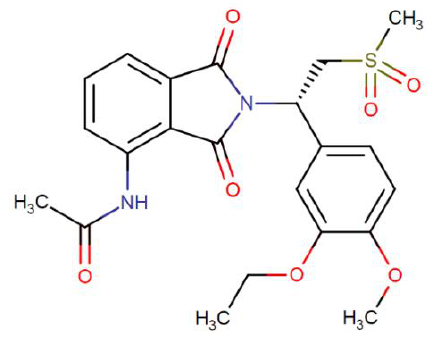
Figure 1. Apremilast chemistry structure.